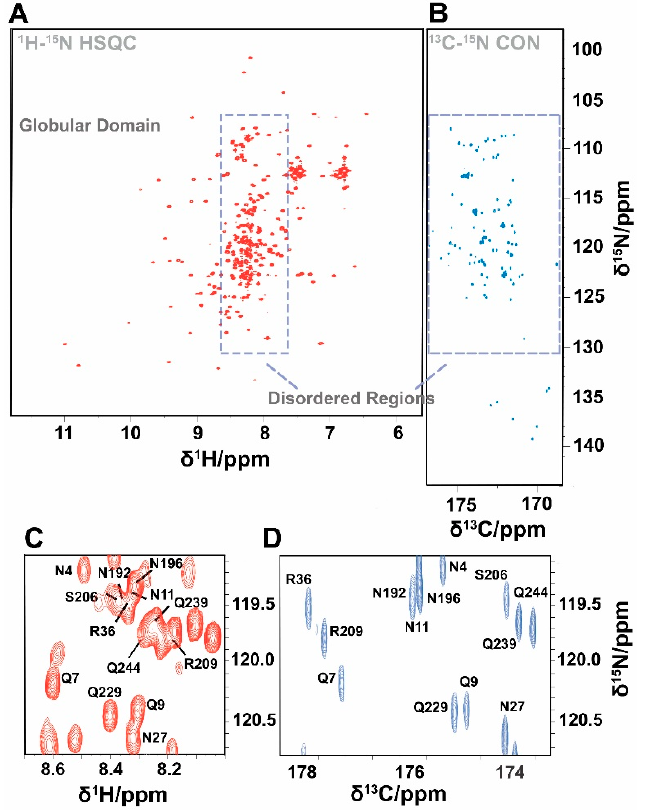
Figure 1. Panels A and B report the spectra obtained through the mr_CON//HN experiment. The 2D HN spectrum ( A ) shows a set of well-isolated signals deriving from the globular NTD domain as well as a number of signals, clustered in a narrow central region of the spectrum, deriving from the IDRs. The 2D CON spectrum ( B ) allows achieving the necessary resolution to investigate resonances from IDRs, including signals of proline residues. While IDR peaks fall in a very crowded region of the HN spectrum (1.1 ppm on 1 H dimension), they are well dispersed in the CON spectrum (7.2 ppm on 13 C dimension), as indicated by the two boxes. A zoom of a region of the two spectra centered at 120 ppm for 15 N is reported in panels ( C , D ) to stress this